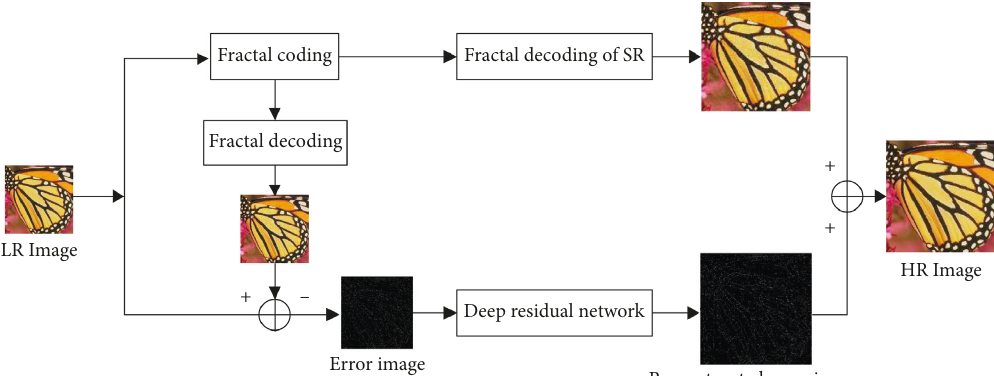
Figure 2: The proposed algorithm flowchart. The input LR image obtains the reconstructed HR image in three steps.